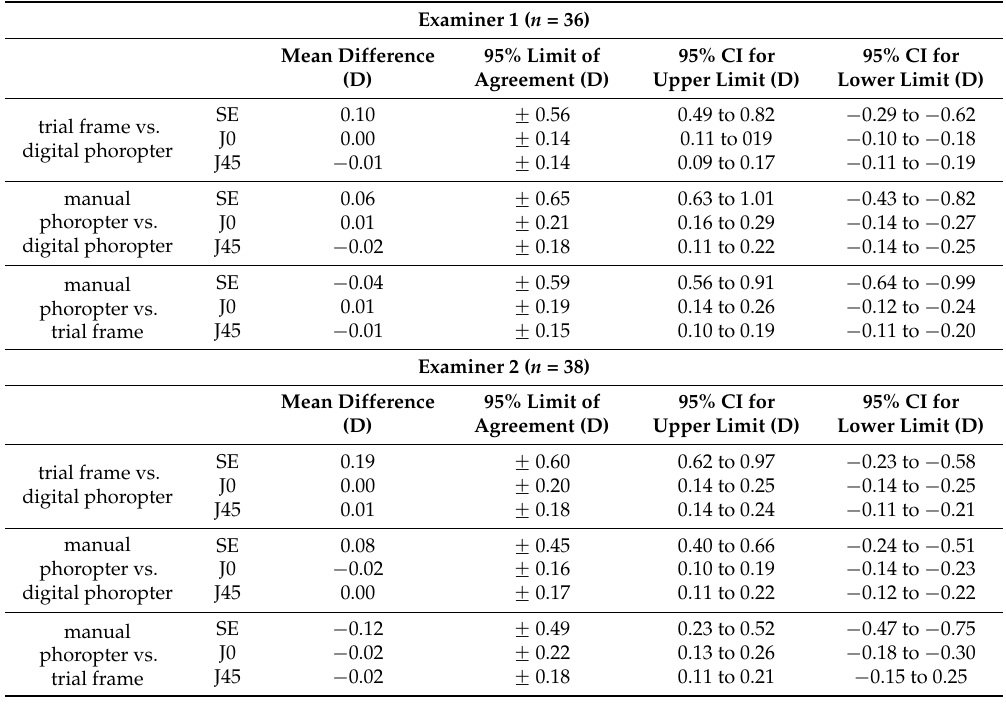
Descriptive analysis for the comparison of the three subjective methods that assess the subjective refractive error, separated for the two examiners. Data represents the Bland-Altmann